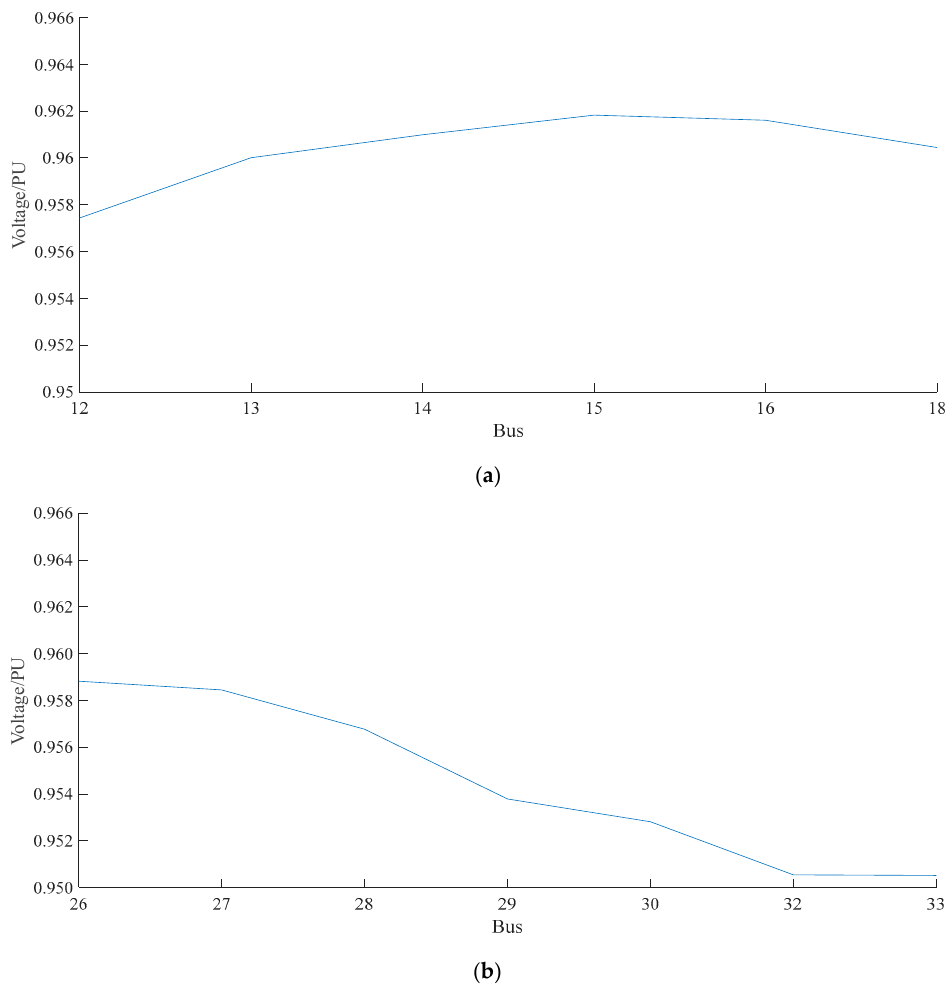
Figure 10. Comparison of the control effects: ( a ) AR 5 bus 17 voltage and ( b ) AR 3 bus 31 voltage.